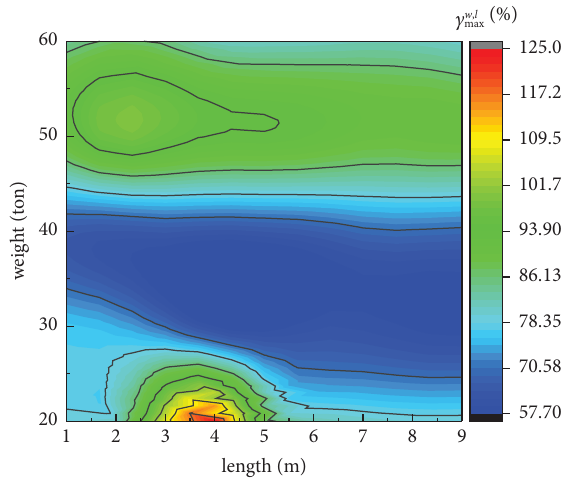
Figure 10: Te c w,l